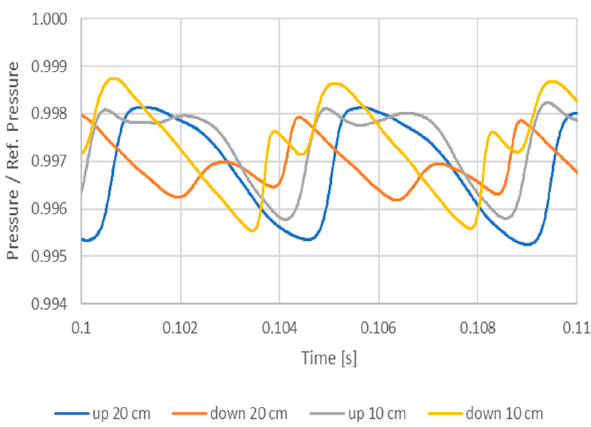
Figure 19. Pressure evolution in the upstream and downstream sections with different damper lengths equal to 10 cm and 20 cm.